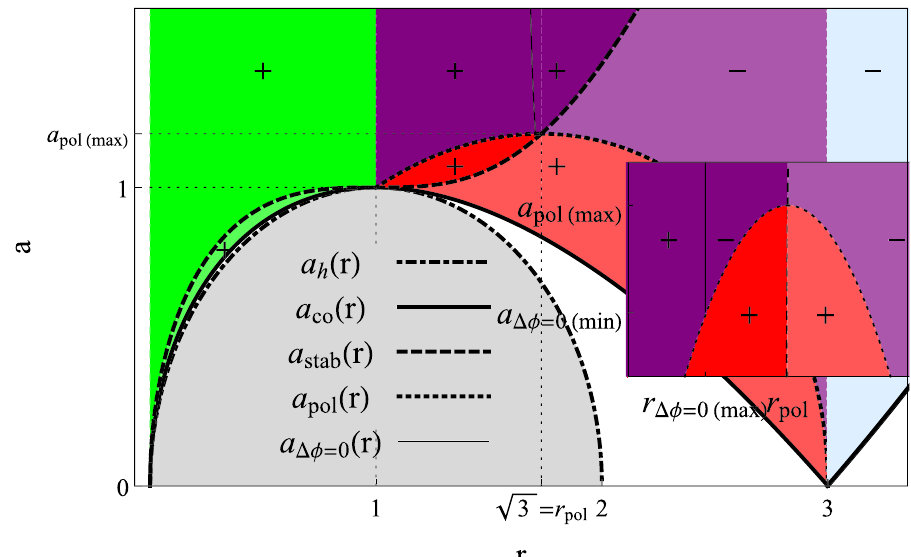
Fig. 14 Characteristic functions a ( r ) with supplementary informa- tions about stability and latitudinal and azimuthal motion for wider interval of the parameter a (above) and in greater detail (bellow). Sig- nificance of the characteristic functions is given in Fig. 1. Gray shad- ing demarcates the dynamic region, colouring highlights region of the SPOs.Orbitswith E < 0 , allbeingpurelyprograde,i.e.,withoutturning